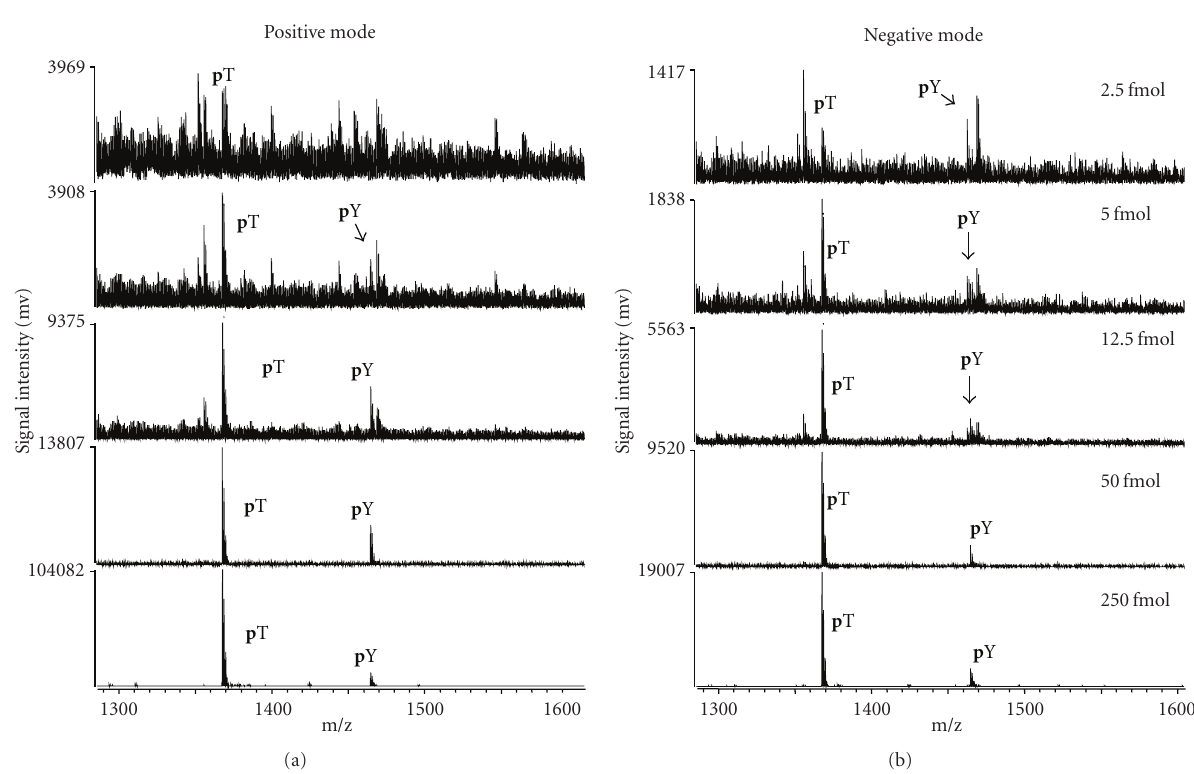
Figure 4: The MALDI mass spectra of two synthesized phosphopeptides p T and p Y mixed at equimolarity from 5 to 250fmol on target, which were measured in positive (a) and negative (b) ion mode with DHAP/DAHC, respectively.